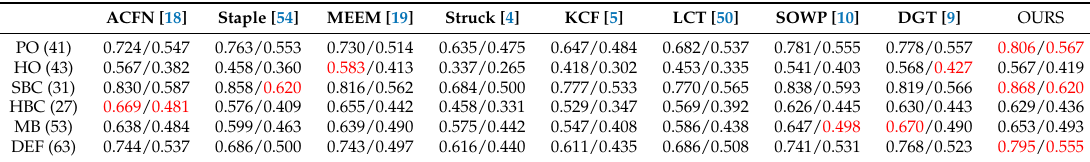
Table 7. The PR/SR score comparison of our tracker with recent state-of-the-art trackers on some challenges of motion blur and different levels of occlusion and background clutter: partial occlusion (PO), heavy occlusion (HO), slight background clutter (SBC), heavy background clutter (HBC), motion blur (MB) and deformation (DEF). The red number is the best result. ACFN [18] Staple